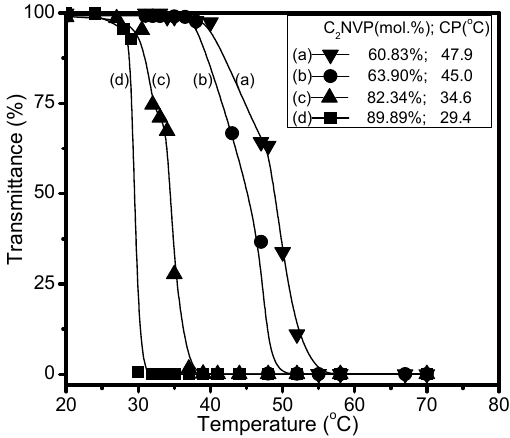
Figure 6. Plot of LCST trends of copolymers with different compositions ( M n ≈ 15300; conc. = 1 mg/mL).